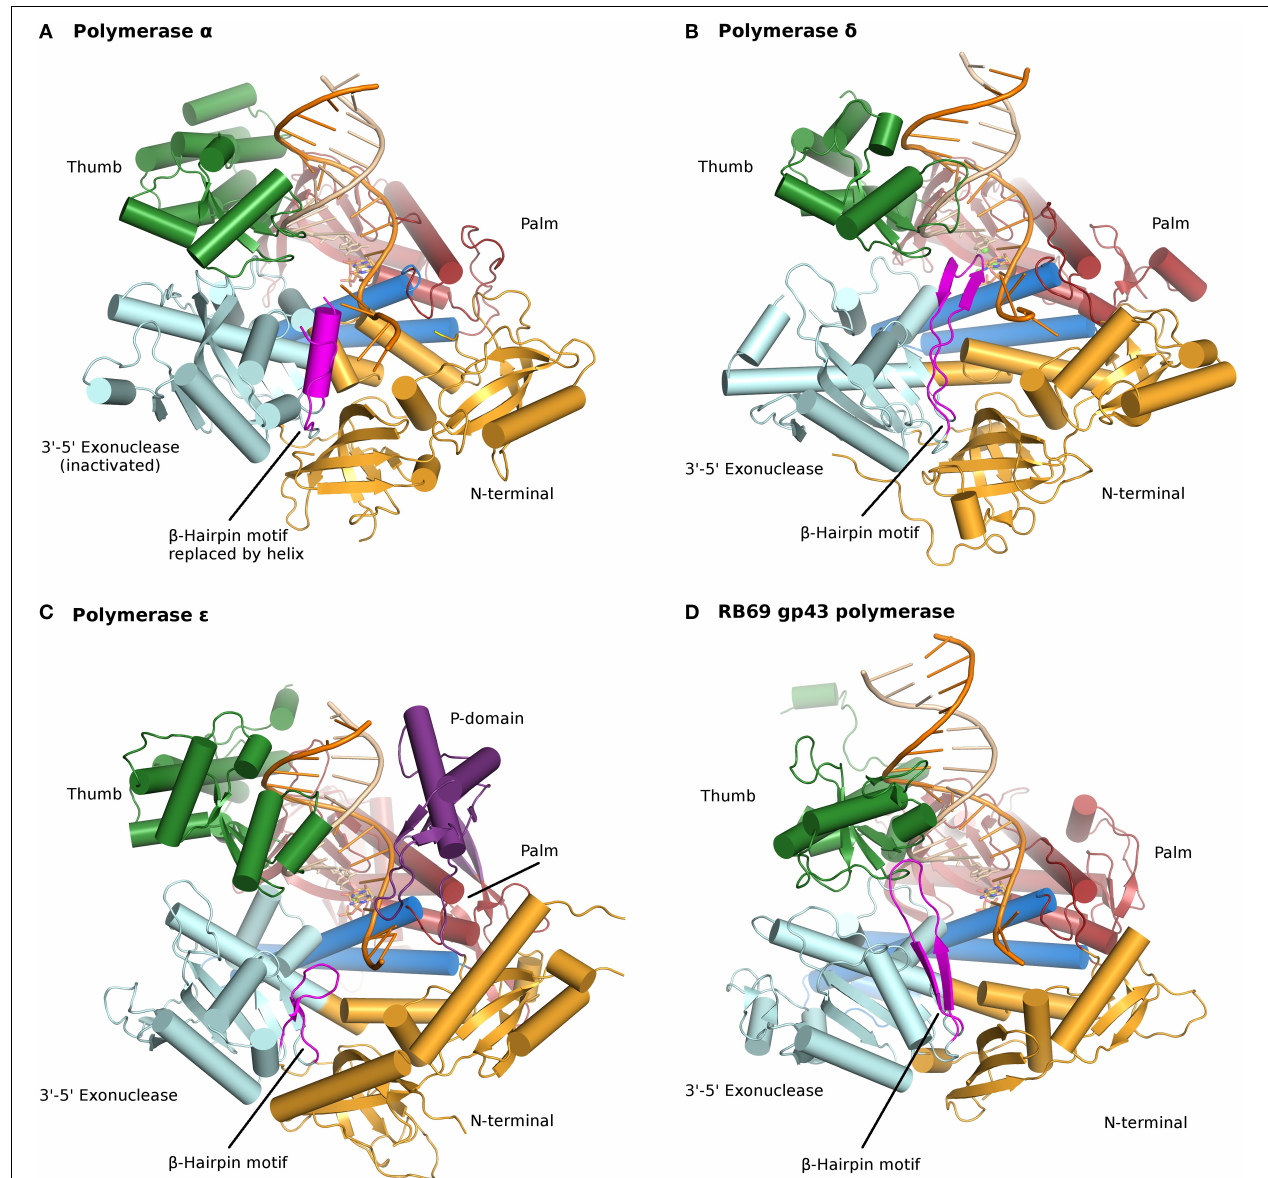
FIGURE 1 | Ternary complexes of polymerases α , δ , ε , and RB69 gp43 are illustrated from identical orientations for comparison. The thumb (green) and fingers (dark blue) domains grasp the duplex nucleic acid (primer shown in beige, template in orange) against the palm domain (red). The N-terminal domain appears in gold, adjacent to the 3 (cid:2) –5 (cid:2) exonuclease domain (cyan). (A) Polymerase α (PDBID 4FYD) binds an RNA/DNA hybrid, where the wide, shallow minor groove of A-form DNA is apparent near the thumb. The 3 (cid:2) –5 (cid:2) exonuclease domain is devoid of activity. A helical region (magenta) in the inactivated exonuclease domain stabilizes the 5 (cid:2) end of the template. (B) Polymerase δ (PDBID 3IAY) harbors a large β hairpin motif (magenta), which is